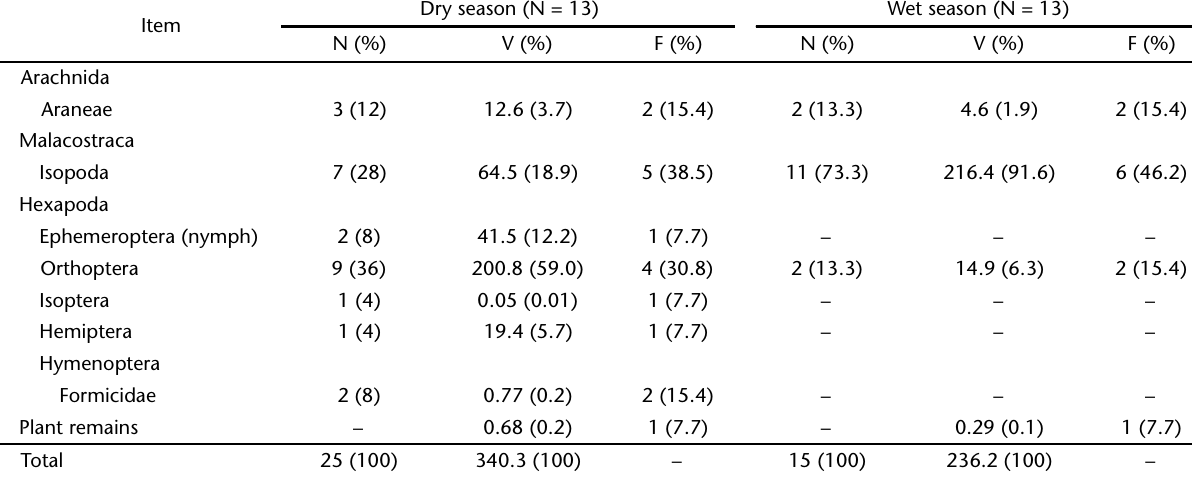
Table I. Number (N), volume (V, mm 3 ), and frequency of occurrence (F) of each category of prey in the diet of Ecpleopus gaudichaudii from the Atlantic Forest in the Reserva Ecológica de Guapiaçu and its surroundings, in southeastern Brazil, during the dry and wet seasons. Percentages values are in